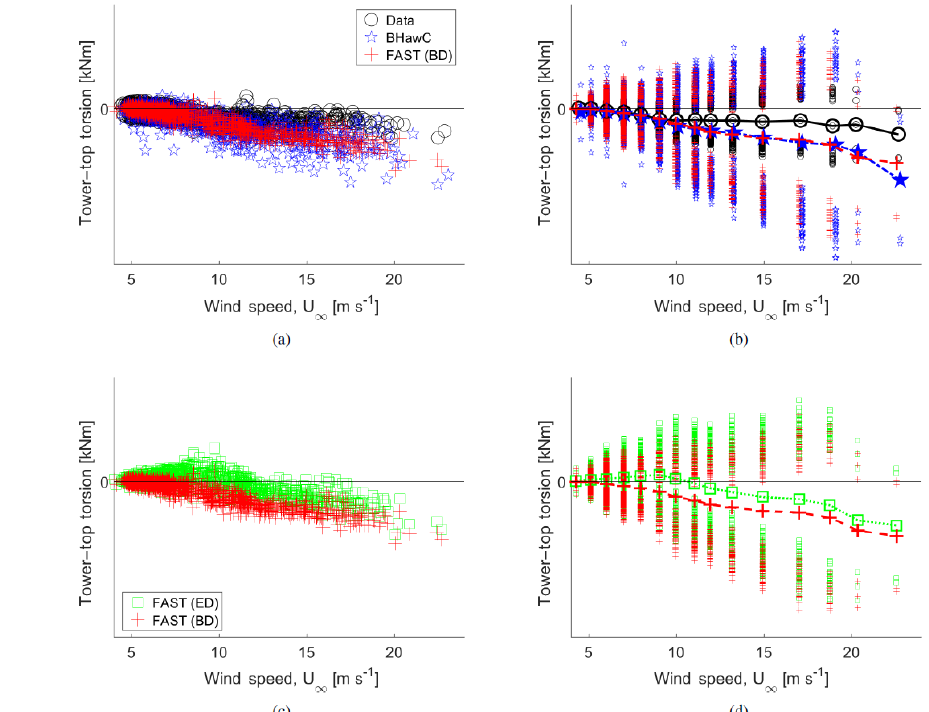
Figure 11. Tower-top torsion moment. (a) Individual 10min averages from experimental data, BHawC, and FAST (BD). (b) Binned averages of data in (a) are denoted by points connected by lines; the scatter above and below these data denotes plus or minus 1 standard deviation, respectively, of the individual 10min data sets in that bin. (c) Individual 10min averages from FAST (BD) and FAST (ED). (d) Binned averages of data in (c) are denoted by the points connected by lines; the scatter above and below these data denotes plus or minus 1 standard deviation, respectively, of the individual 10min data sets in that